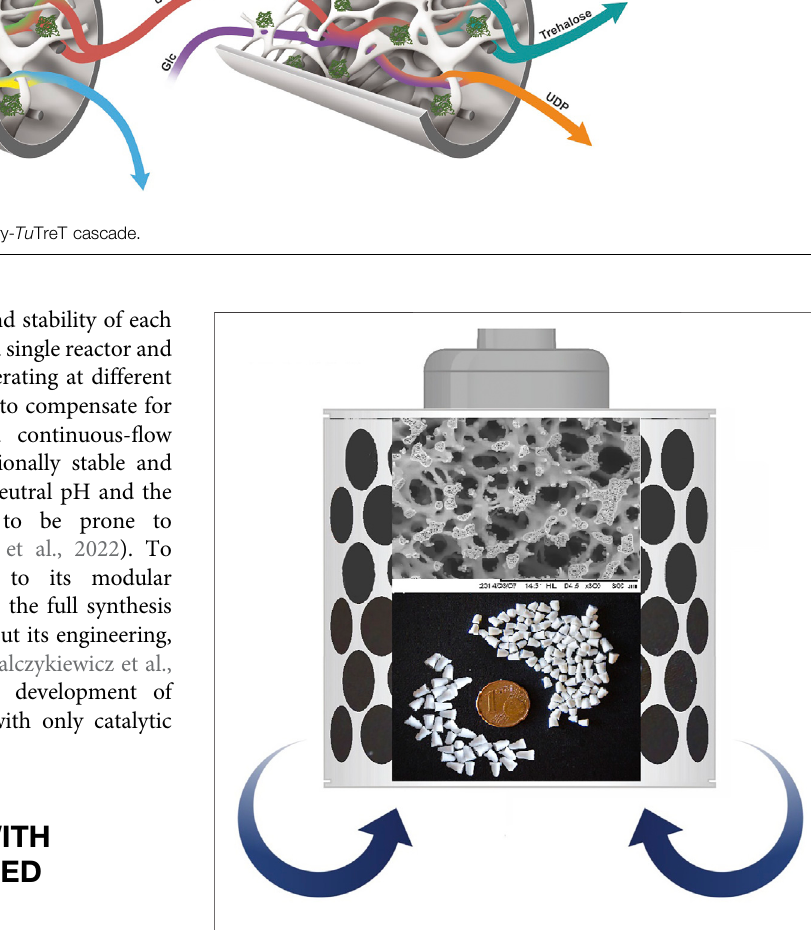
FIGURE 5 | Silica pellets used in the SpinChem